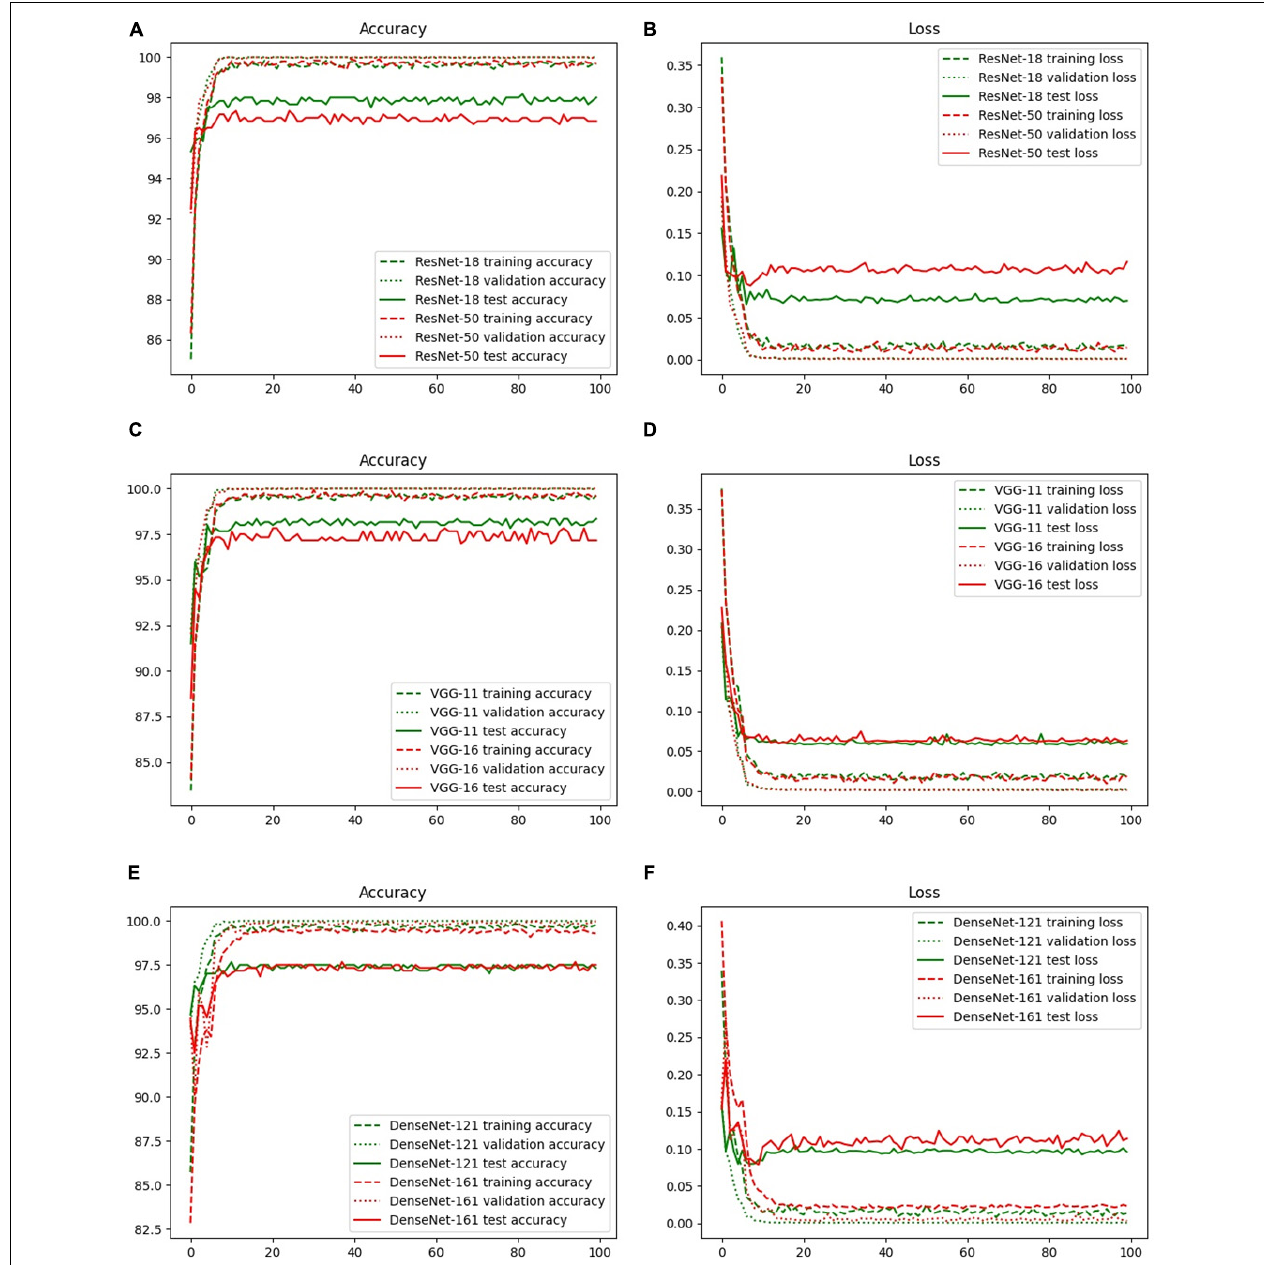
FIGURE 6 | Accuracy and loss curves with different backbones: (A) ResNet-18, (B) ResNet-50, (C) VGG-11, (D) VGG-16, (E) DenseNet-121, and (F)